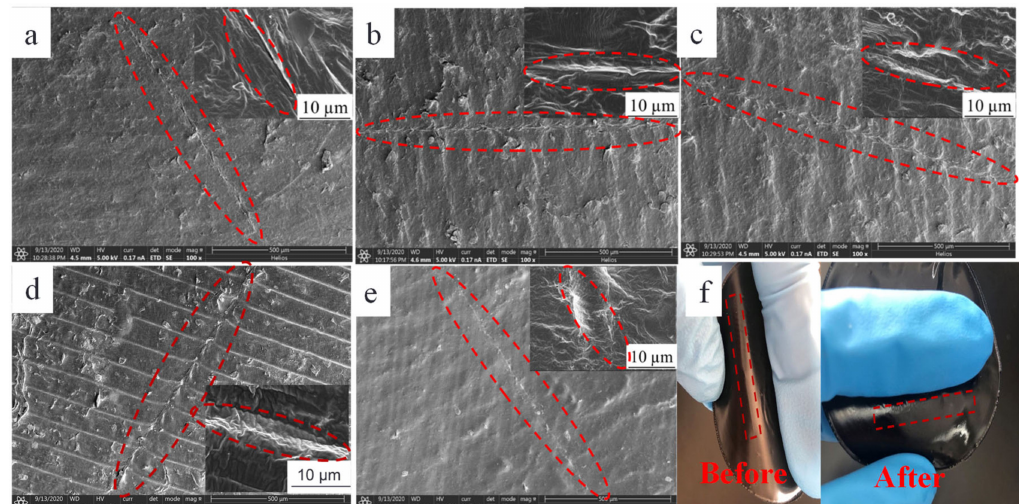
Figure 12. SEM images of the composite films prepared with 20 wt% of the initial TPU concentration and 2 wt% of graphene loading healed under IR irradiation at 110 ◦ C ( a ), 120 ◦ C ( b ), 130 ◦ C ( c ), 140 ◦ C ( d ) and 150 ◦ C ( e ) for 10 min and photographs of samples before and after being healed at 150 ◦ C ( f ).